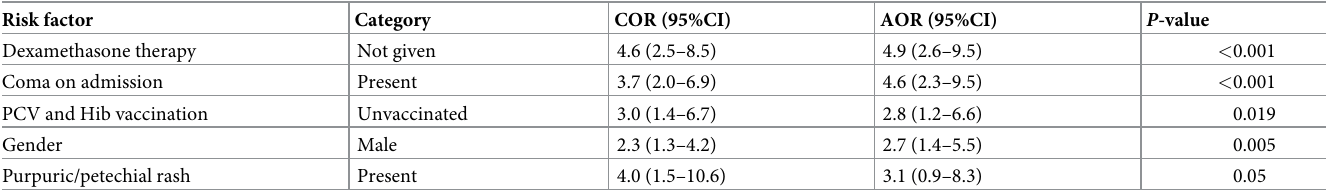
Table 6. Independent factors associated with death in our children with